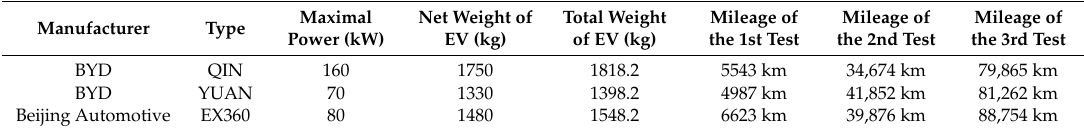
Table 1. Electric vehicles (EVs) tested. Total weight of EV includes the weight of one driver and the measurement